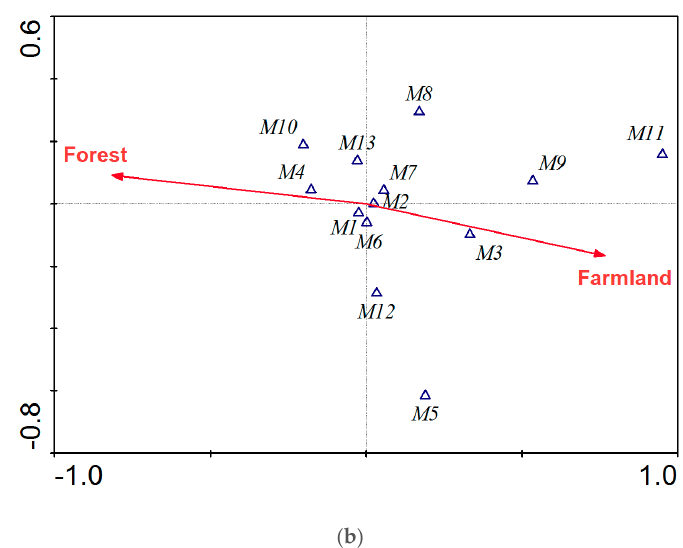
Figure 2. pCCA ordination diagram of stressors and taxonomic structure ( a ) (SC: Specific conductivity) and functional structure ( b ) of fish assemblages in the Taizi River catchment (M1: Proportion pelagic species; M2: Proportion of benthic species; M3: Proportion of piscivores; M4: Proportion of omnivores; M5: Proportion of herbivores; M6: Proportion of detritivores; M7: Proportion of as tolerant species; M8: Proportion of sensitive species; M9: Proportion of pelagic − egg species; M10: Proportion of demersal − egg species; M11: Proportion of viscidegg − species).